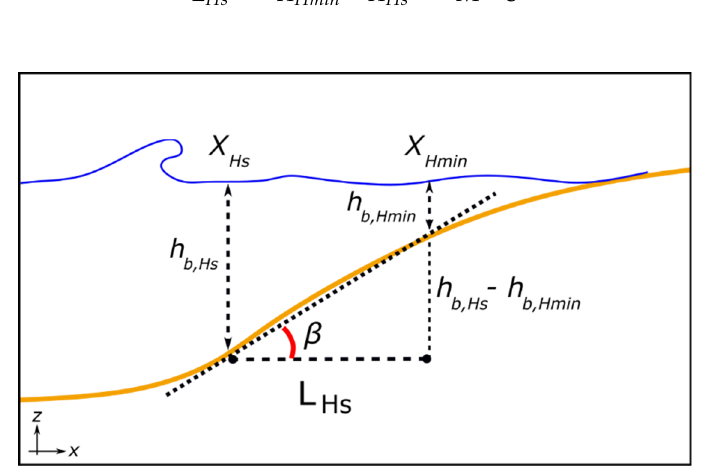
Figure 4. Empirical model sketch. The two breaking fractions X Hs and X Hmin are shown on sea surface (blue line), and β is the average beach slope (orange line) between the two positions.